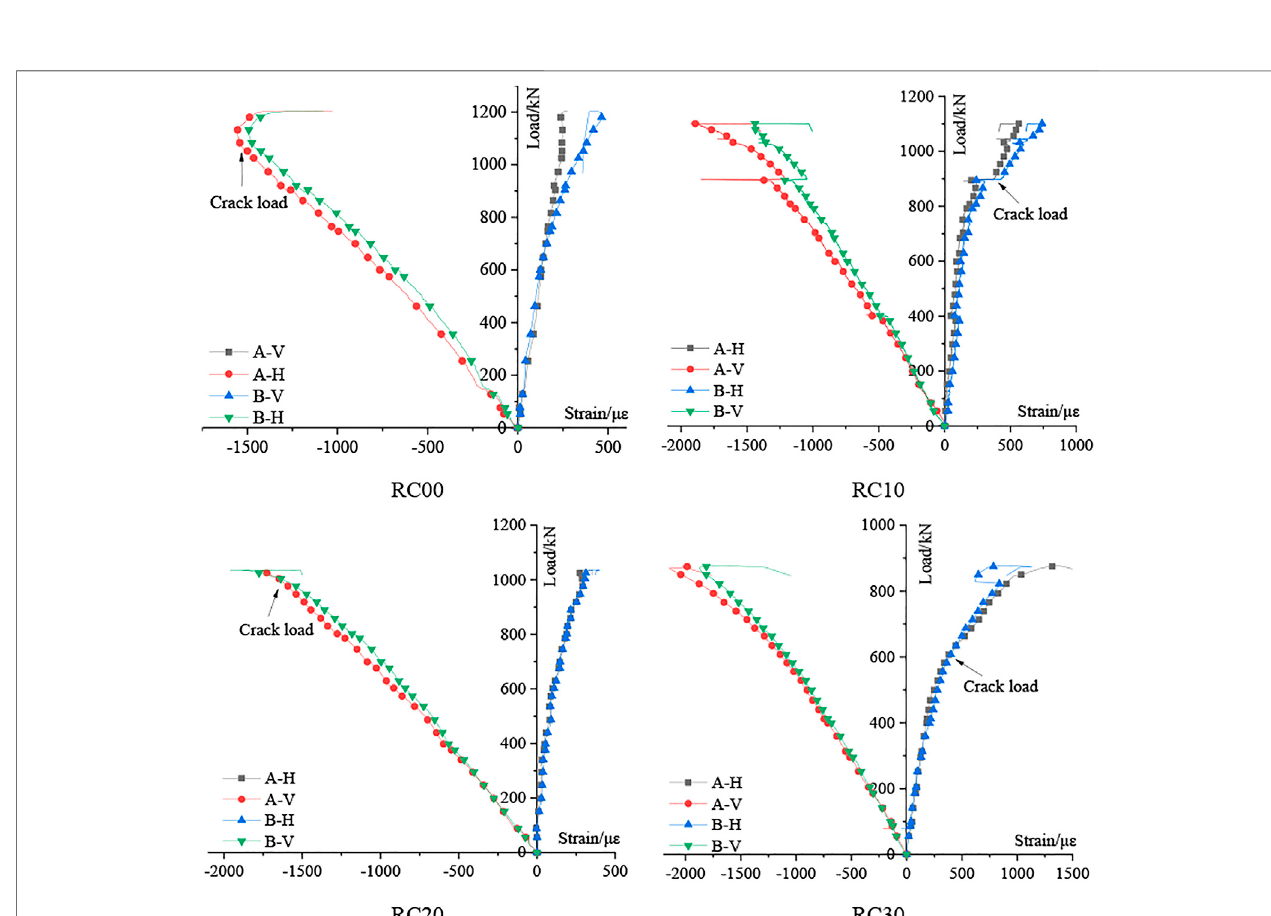
FIGURE 8 | Load-strain curve of unreinforced columns.